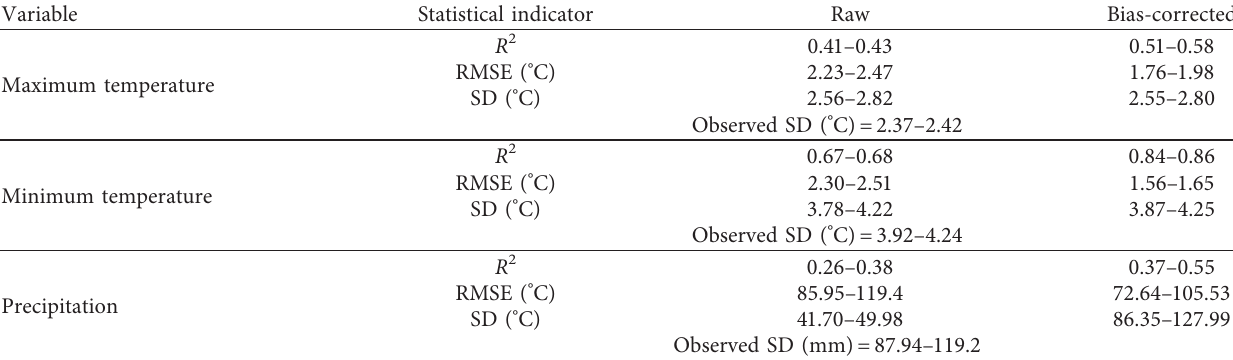
Table 3: Results of bias correction.